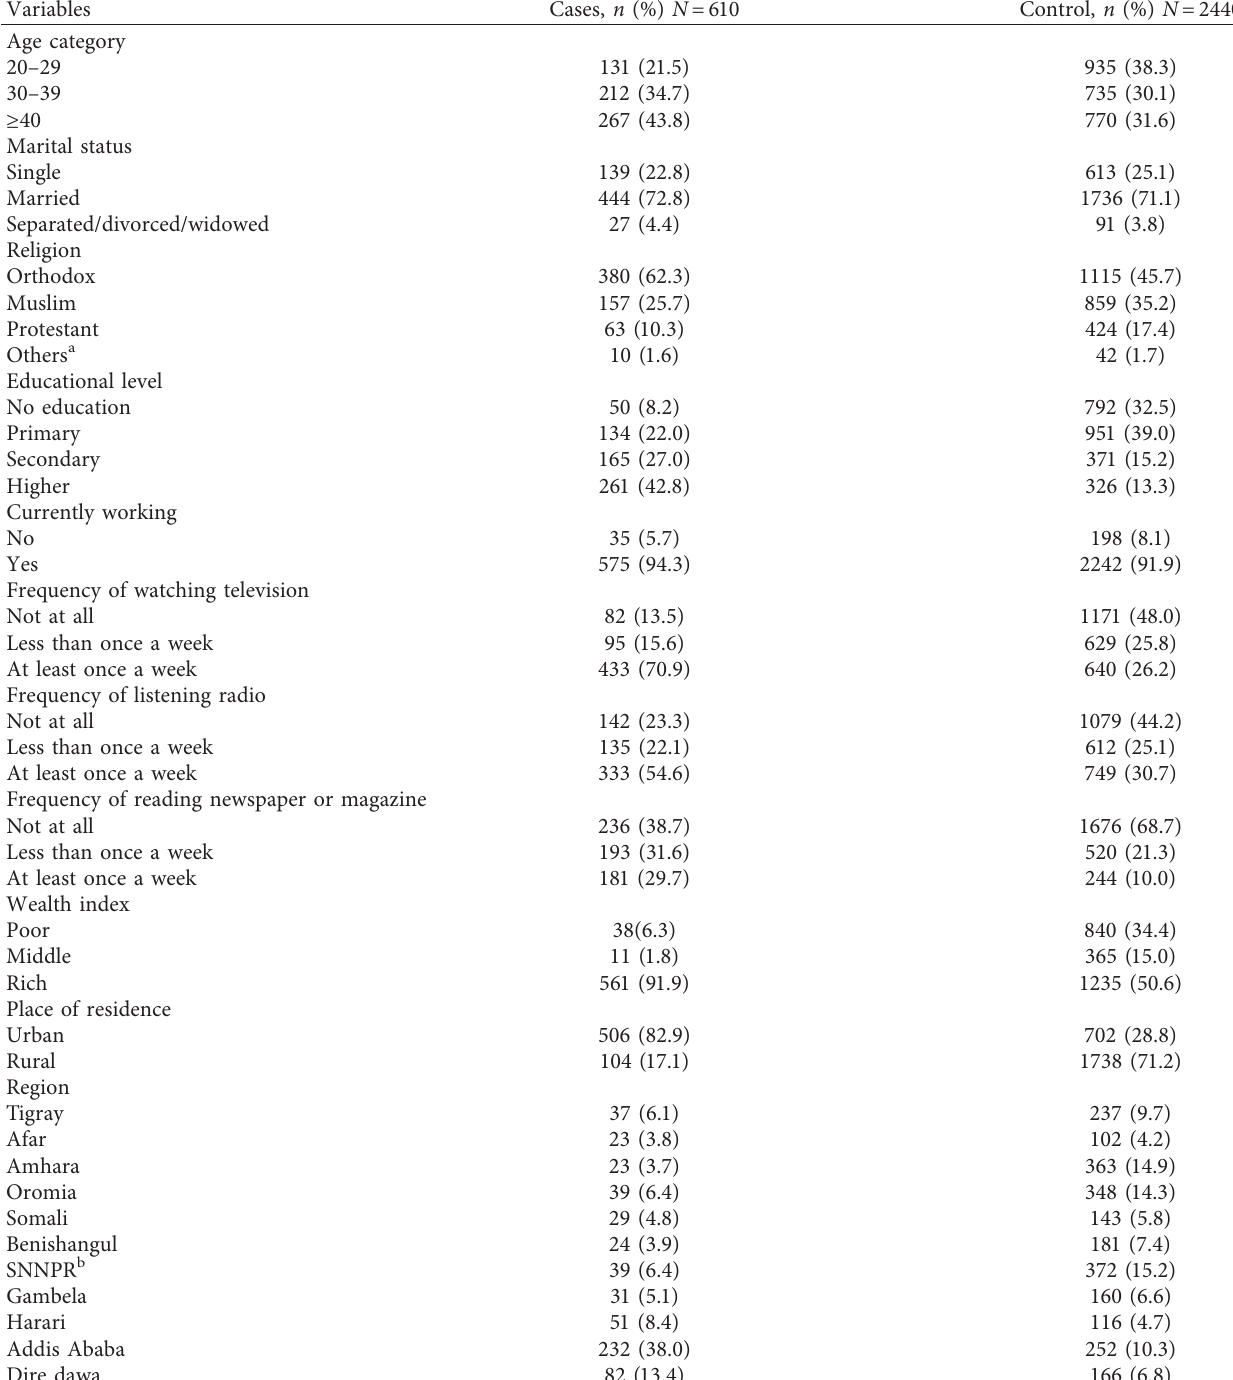
Table 1: Sociodemographic characteristics of men aged 20–59, EDHS,